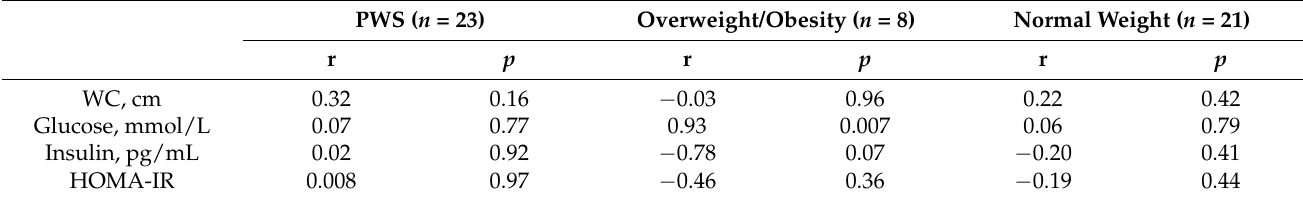
Table 3. Partial correlations of fasting asprosin to other metabolic parameters adjusting for age and sex in children with Prader–Willi syndrome, overweight/obesity, and normal weight.